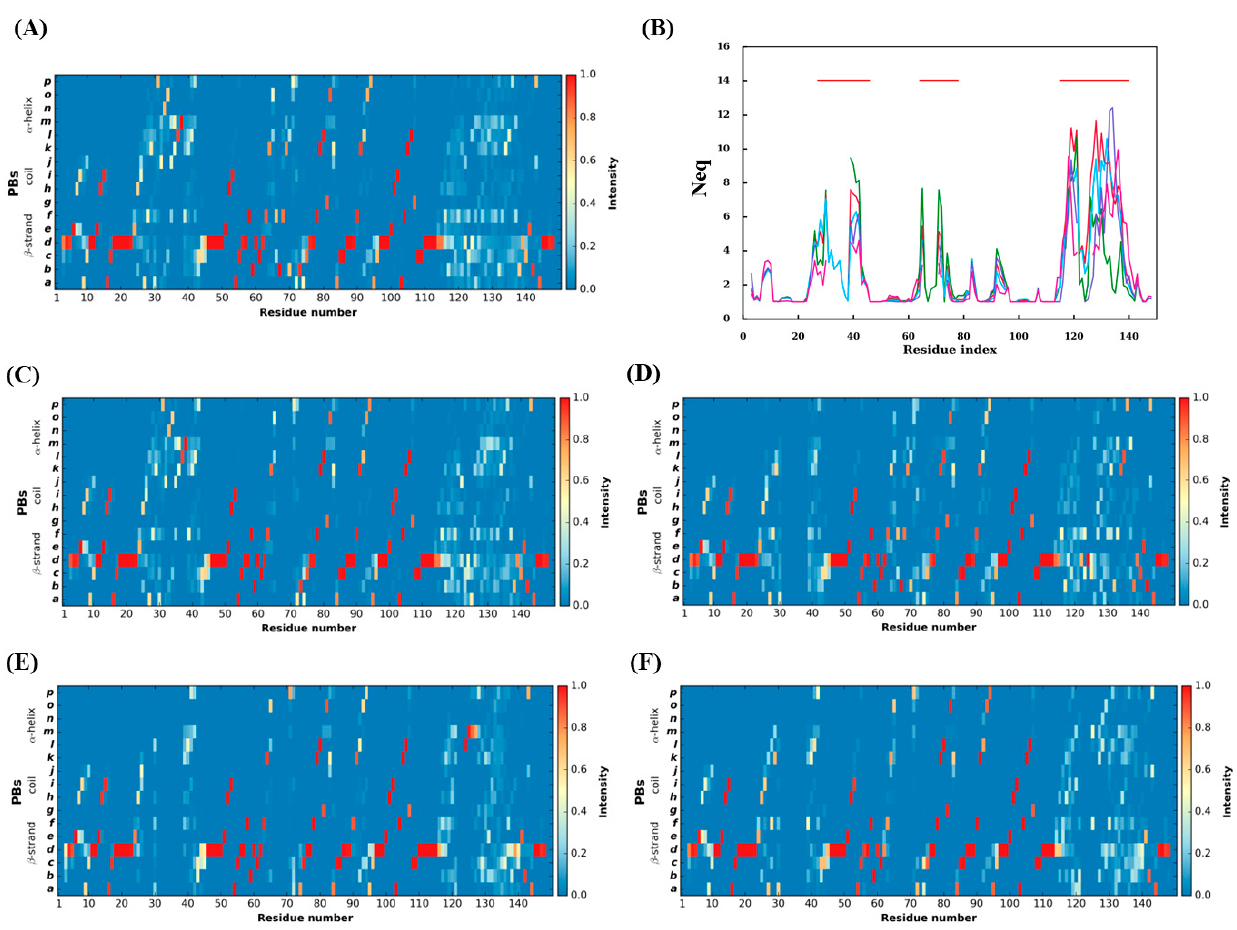
Figure 7. Local backbone diversity at the light of PBs. ( A ) PB map of all V H H trajectories aligned according to MSA, ( B ) N eq values (red line—all V H H trajectories, sky blue—V H H trajectories belonging to RMSF cluster 1, green—V H H trajectories belonging to RMSF cluster 2, purple—V H H trajectories belonging to RMSF cluster 3 and pink—V H H trajectories belonging to RMSF cluster 4), PBs map of V H H trajectories belonging to ( C ) from RMSF cluster 1, ( D ) from RMSF cluster 2, ( E ) from RMSF cluster 3 and ( F ) from RMSF cluster 4. The x -axis represents the residue positions, and the y -axis represents the types of PBs or the N eq .